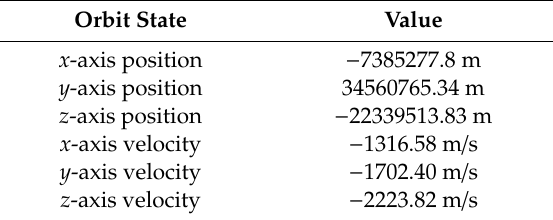
Table 2. Initial orbit state of the